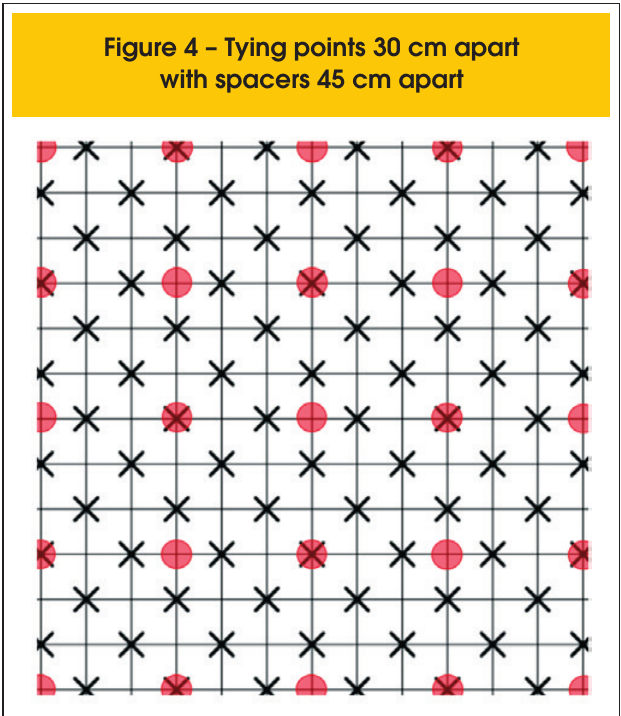
Figure 3 – Tying points 15 cm apart with spacers 45 cm apart